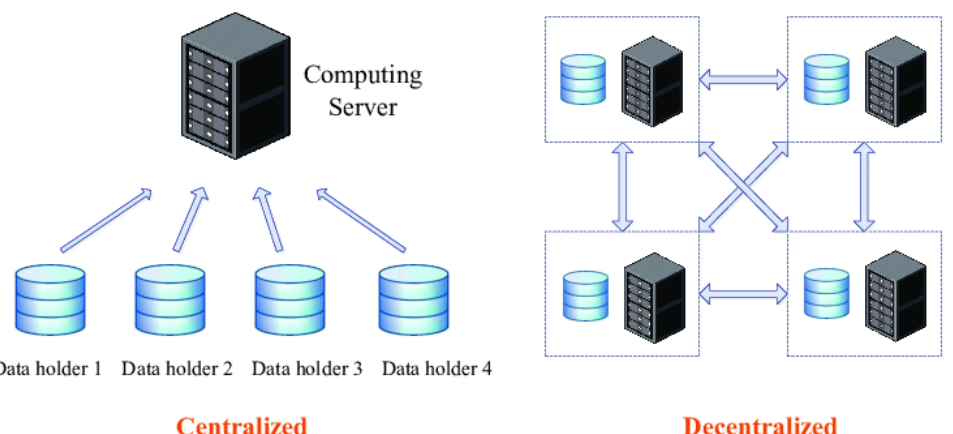
Figure 3. Architecture design of centralized FL vs. decentralized FL